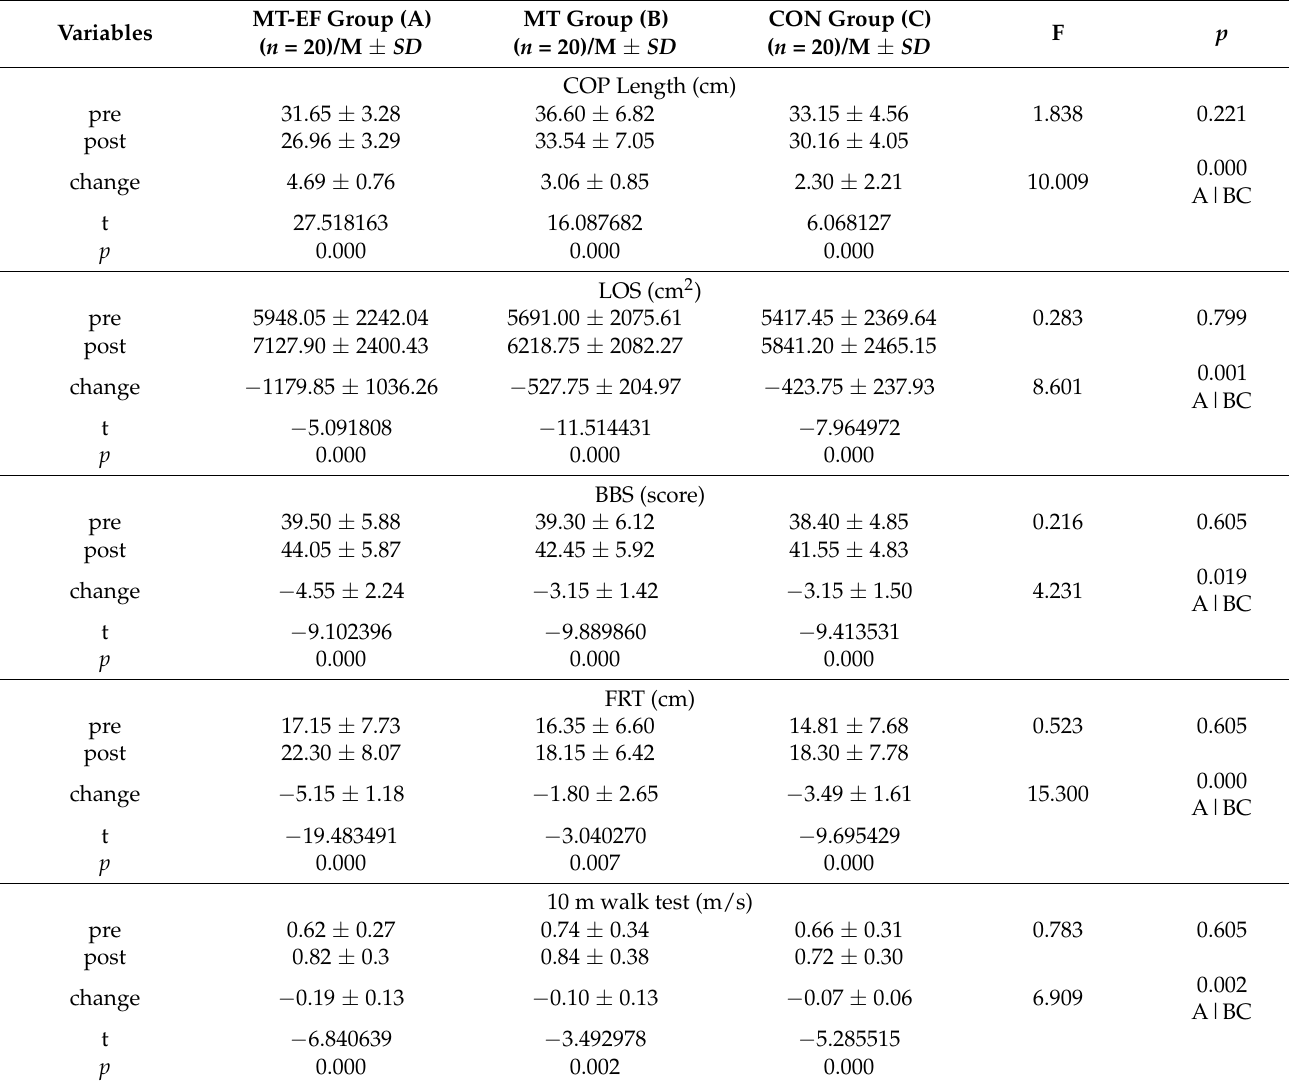
Table 2. Comparison pre and post test among three groups ( n =